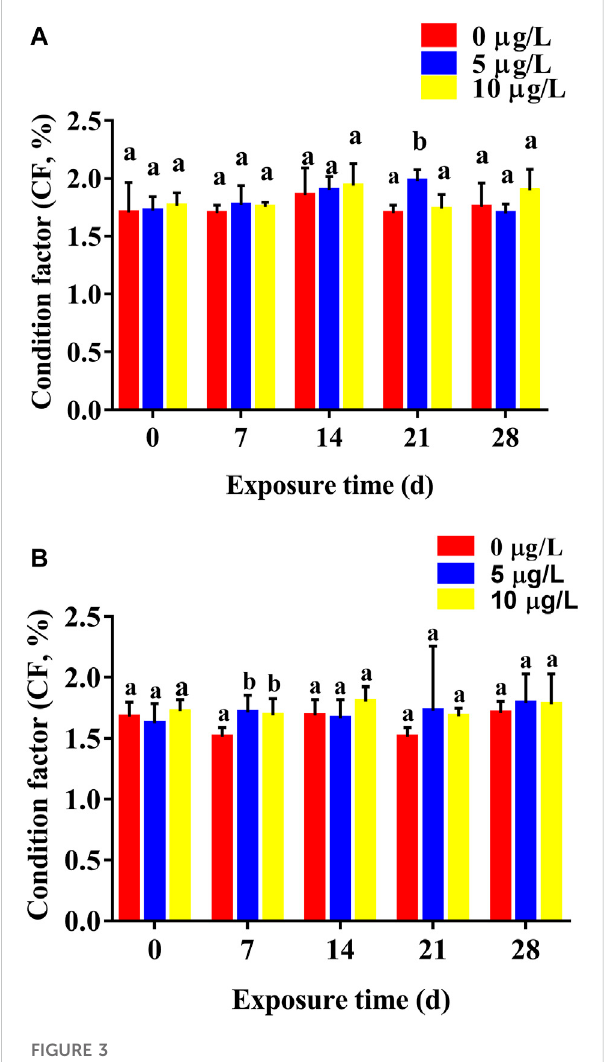
FIGURE 4 Gonadosomaticindex(mean±SD)ofrareminnows( Gobiocypris rarus ) exposed to 0, 5, and 10 μ g/L Cd for 28 days ( n = 3). (A) Female rare minnows; (B) Male rare minnows. Bar with different letters between the control and exposed groups in the same day indicates statistically signi fi cant differences ( p <